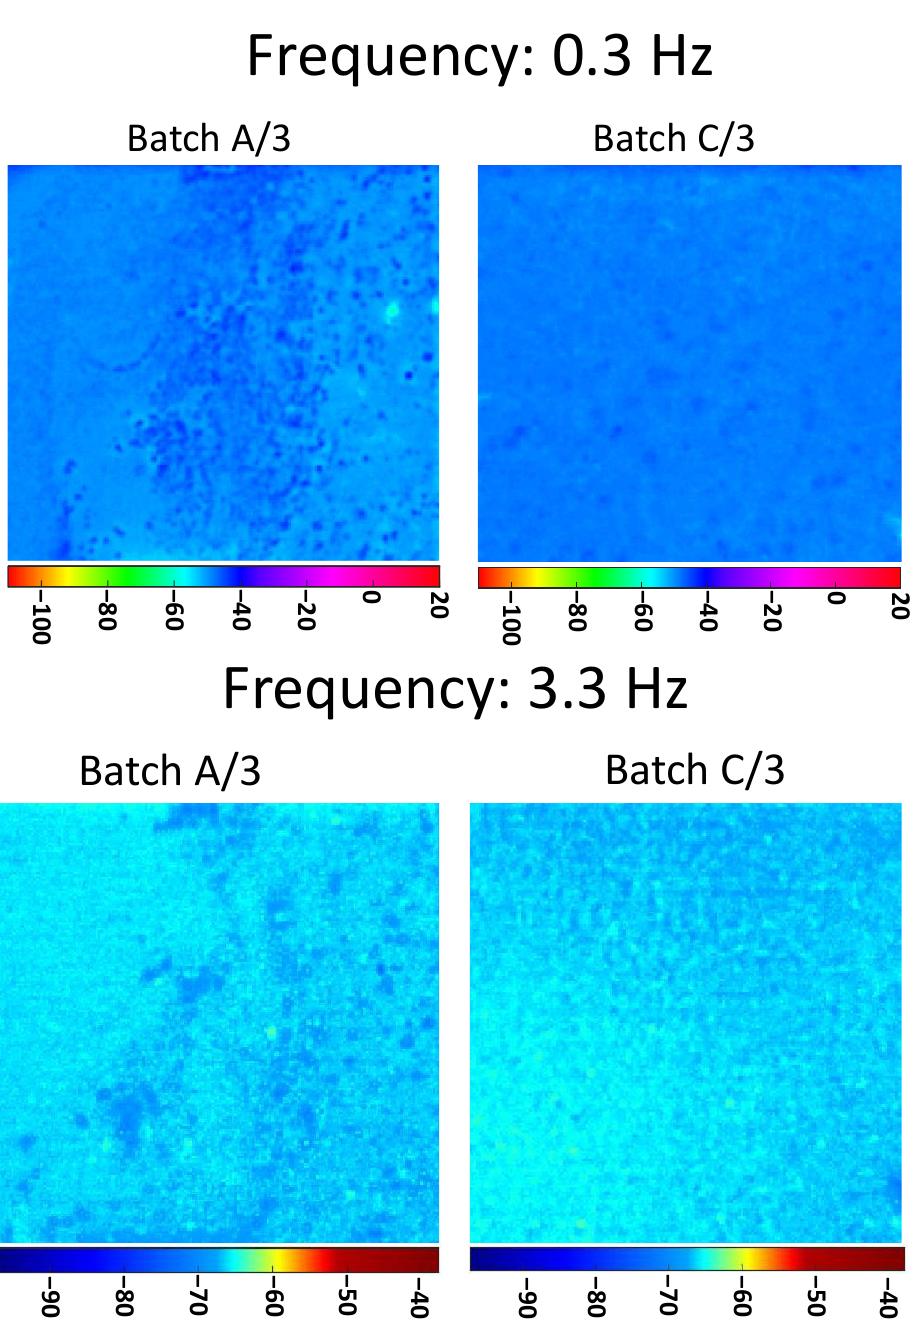
Figure 7. PPT phasegrams comparison of samples coming from A/3 and C/3; on the first row phasegrams computed at selected frequency of 0.3 Hz, on the second row phasegrams computed at selected frequency 3.3 Hz.